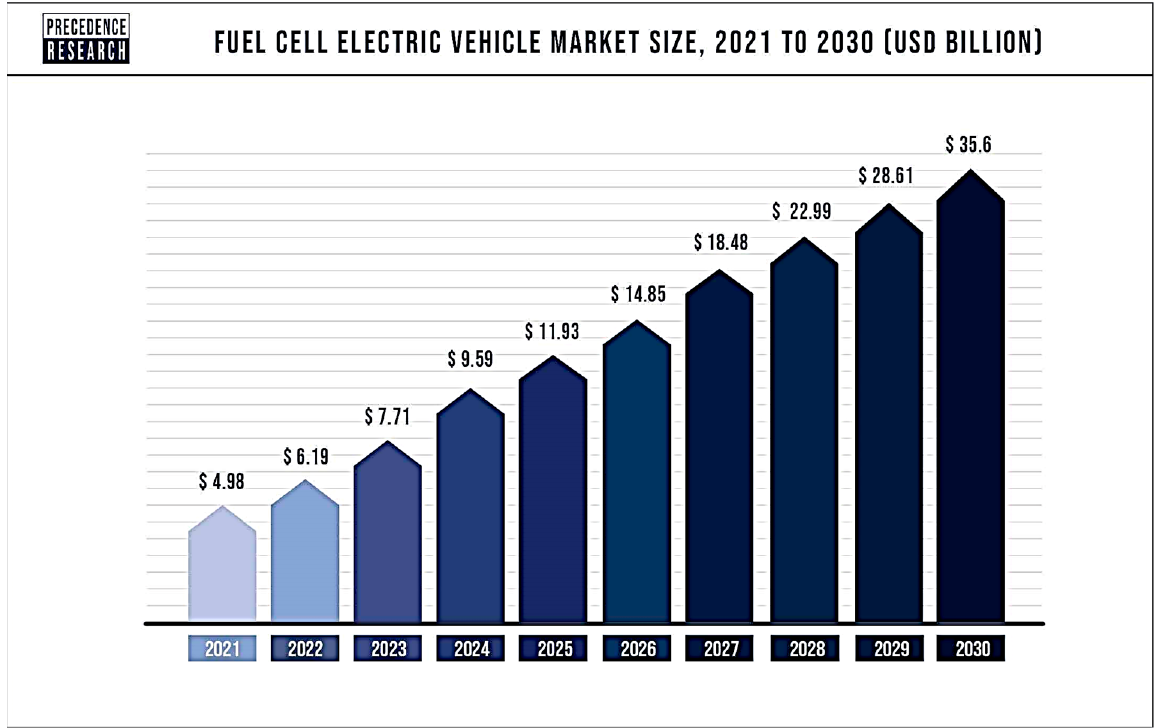
Figure 3. Fuel cell EV market [14].